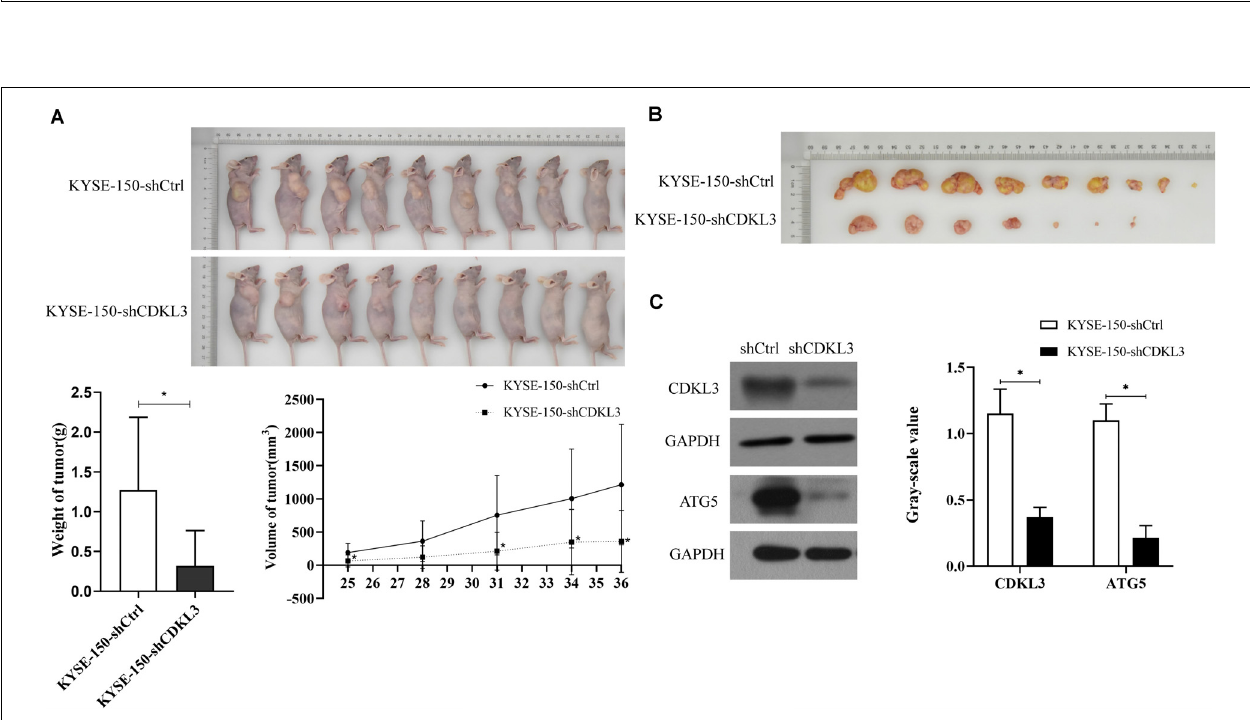
Frontiers in Oncology |